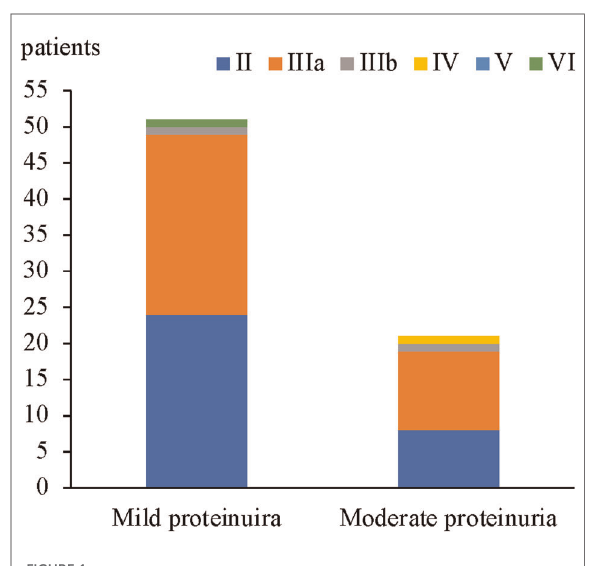
FIGURE 1 Renal pathological grades in the mild proteinuria and moderate proteinuria groups.